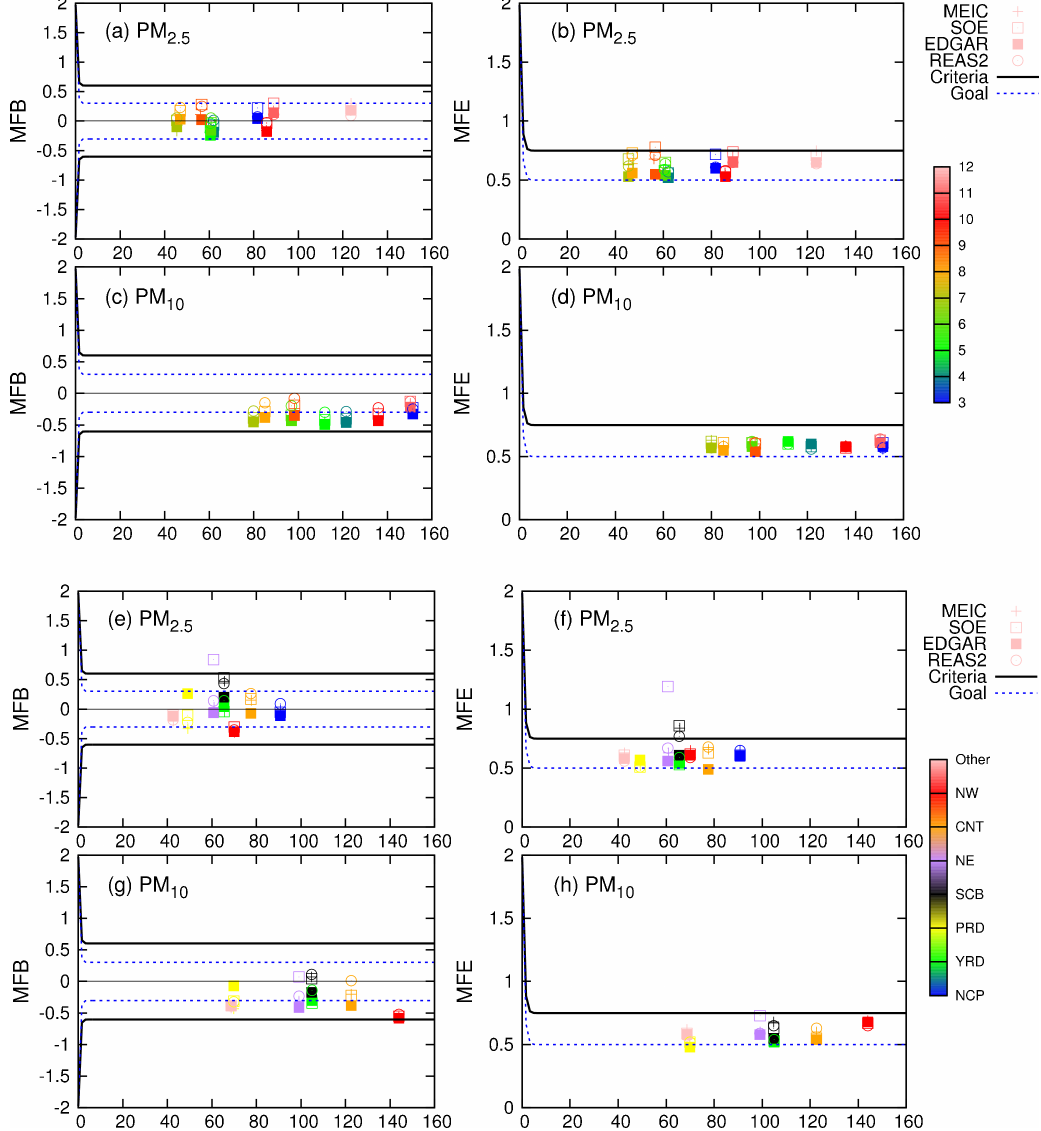
Figure 3. Performance of predicted PM 2 . 5 and PM 10 for different months (a–d) and regions (e–h) based on simulations with individual inventories. The x axis is the observed concentrations. The model performance criteria (solid black lines) and goals (dash blue lines) are suggested by Boylan and Russell (2006). The model performance goals represent the level of accuracy considered to approximate the best a model could be expected to achieve, and the model performance criteria represent the level of accuracy that is considered to be acceptable for modeling applications. Changes in colors show the months from March to December in the top two rows (3 refers to March, 12 to December, etc.), while they show regions from NCP to Other in the bottom two